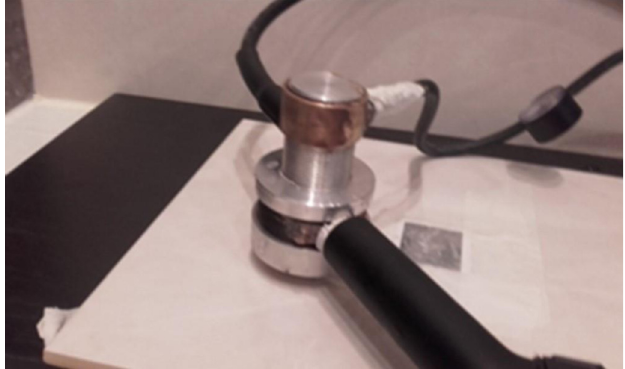
Fig. 4. Image of cavitation generating head with water